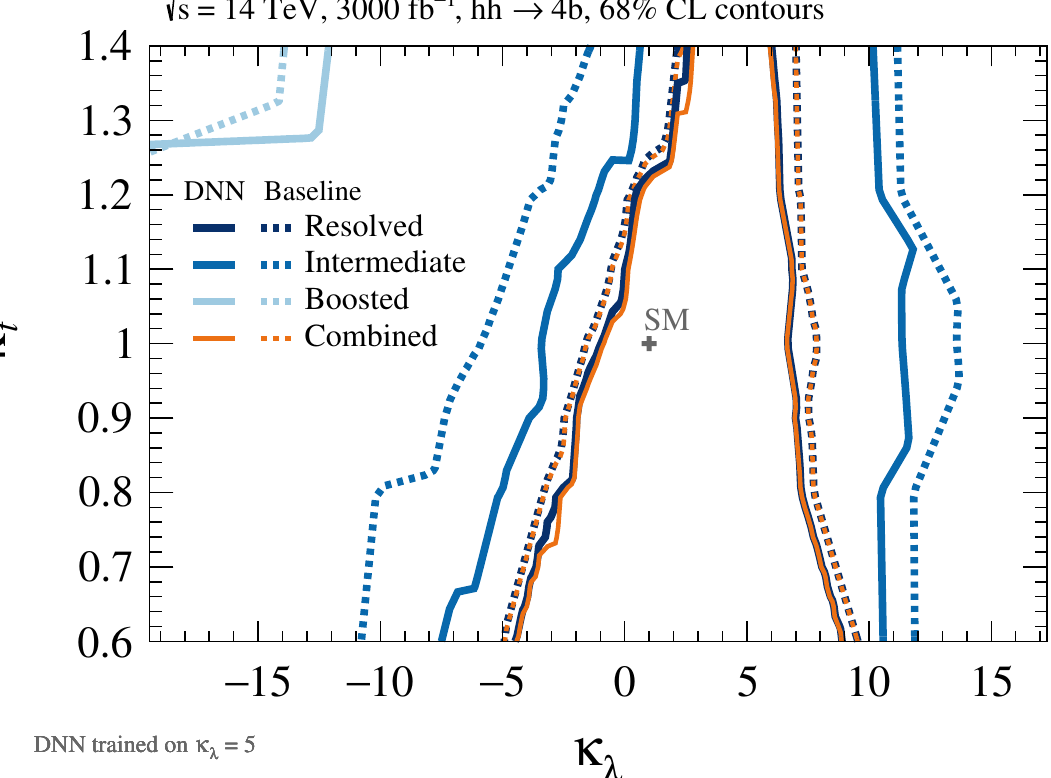
Figure 15. Summary of 68% CL ( χ 2 = 1) contours in the κ t vs κ λ plane. These are displayed for the resolved (dark blue), intermediate (medium blue), boosted (light blue) categories and their combination (orange) for the baseline analysis (dashed) and neural network analysis (DNN) trained on κ λ = 5 (solid). A luminosity of 3000 fb − 1 is assumed along with systematic uncertainties of 0.3%, 1% and 5% for the resolved, intermediate and boosted categories, respectively. The cross indicates the SM prediction. The combined χ 2 distributions are displayed in figure 14 and the χ 2 distributions for each analysis category are shown in appendix